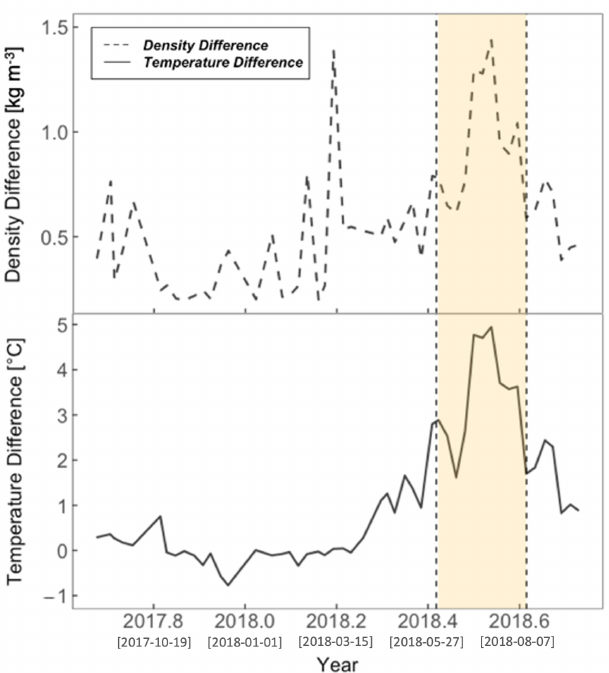
Figure 7. Density and temperature difference between the surface (0 to 5m) and bottom (45 to 50 m) at L4, used as a stratification index. High stratification is indicated by a higher difference value. The yellow shaded area represents the summer period June to August. Square bracketed dates on the x-axis ticks represent